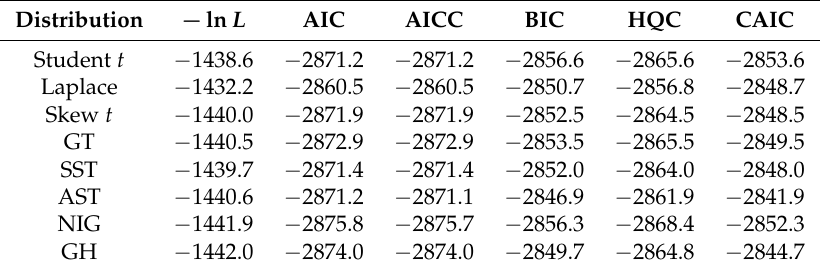
Table 9. Fitted distributions and results for daily log returns of the exchange rates of Monero from